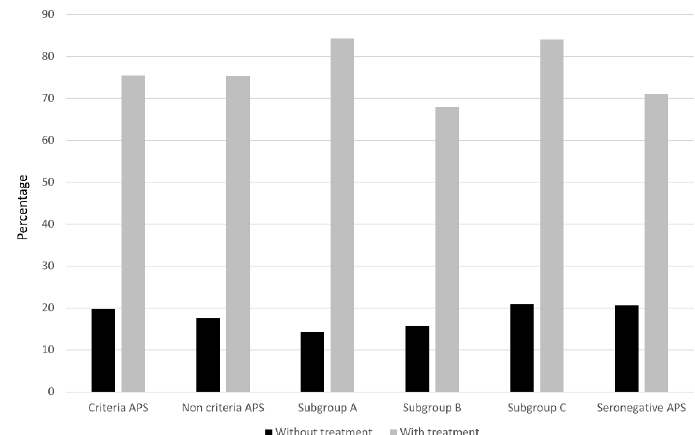
Figure 3. Proportion of successful pregnancy in the study groups after standard treatment. The results show the percentage of live births compared to the number of patients with or without standard (SoC) treatment.